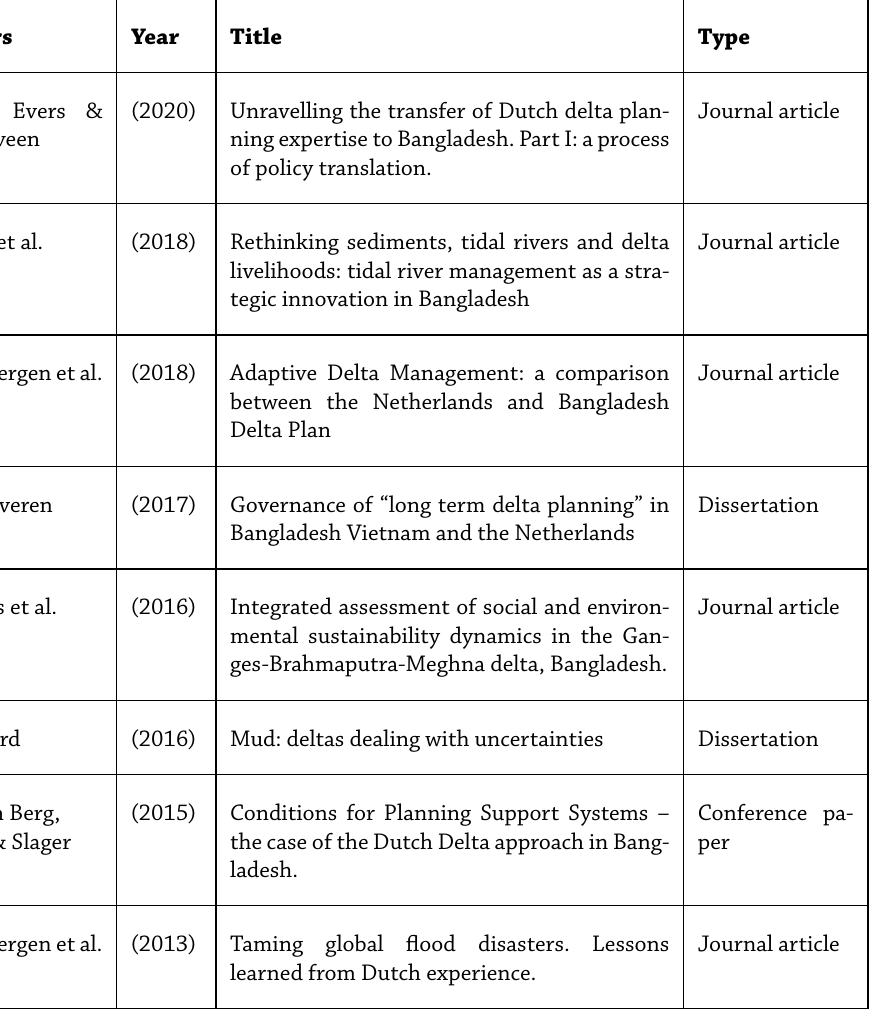
Table A.2 Overview of the literature on the Bangladesh Delta Plan 2100